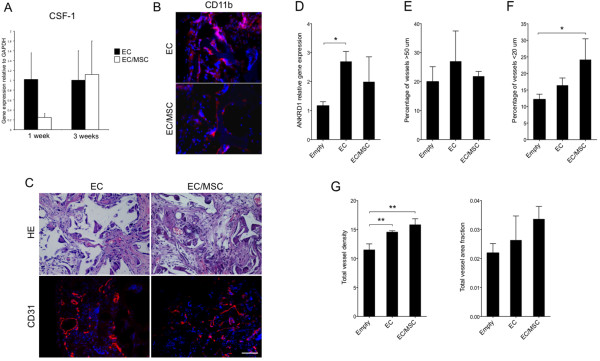
Inflammation and vascularization of scaffolds after three weeks implantation. (A) Early expression of human specific macrophage colony stimulating factor-1 (CSF-1) one week after implantation was higher in mono-culture, although not statistically significant (P = 0.079). Three weeks after implantation a difference could no longer be found. (B) Staining for CD11b, a protein subunit of the macrophage-1 antigen, was positive on the surface of the implanted constructs three weeks after implantation for both experimental groups. (C) Functional blood vessels were identified on H & E staining by the presence of erythrocytes in the lumen and through CD31-staining. Nuclei were stained with DAPI (blue). 20x magnification, scale bar = 100 μm. (D) The expression of ankyrin repeat domain 1 (ANKRD1) associated with EC activation was up-regulated in mono-cultured ECs compared with empty controls. * = P <0.05. (E) The distribution of vessels three weeks after implantation showed a higher percentage of vessels >50 μm in the EC-group: however, it was not statistically significant. (F) The percentage of vessels <20 μm was highest in EC/MSC-constructs. * = P <0.05. (G) Both cellular constructs had a higher vascular density at the end of the experimental period compared with empty control scaffolds. ** = P <0.01. The difference between the experimental groups was not statistically significant. The same tendency was observed for the total area fraction of CD31+ cells, but statistically significant differences were not found. DAPI, 4',6-diamidino-2-phenylindole; ECs, endothelial cells; MSC, meschymal stem cells.